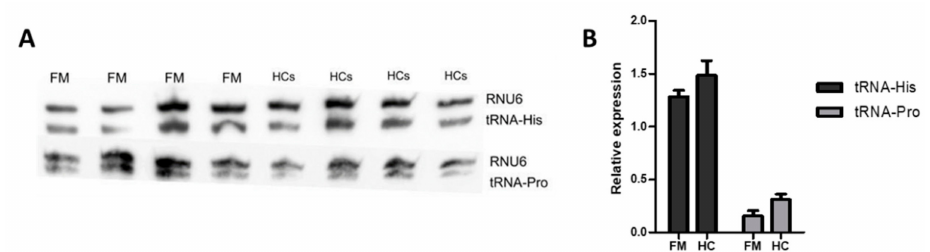
Figure 5. Northern blot analysis of tRNA levels in PBMCs from FM or HC participants, as indicated ( A ). Quantitated tRNA-His, tRNA-Pro levels (Image J software) upon normalization to RNU6 levels are shown ( B ) (N = 4 /